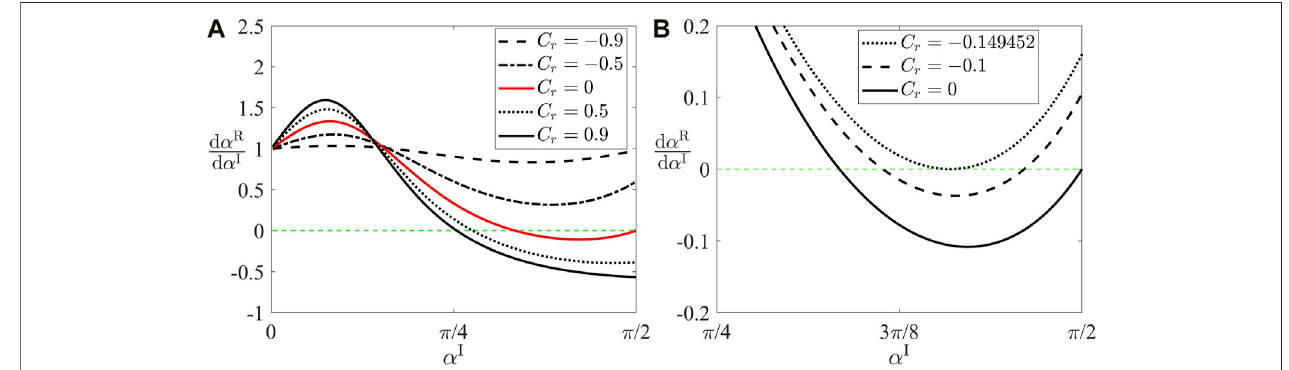
FIGURE 8 | The derivative of re fl ection angle α R with respect to the incidence angle α I . (A) Whole range of C r , (B) Zoom-in range of C r with two zero